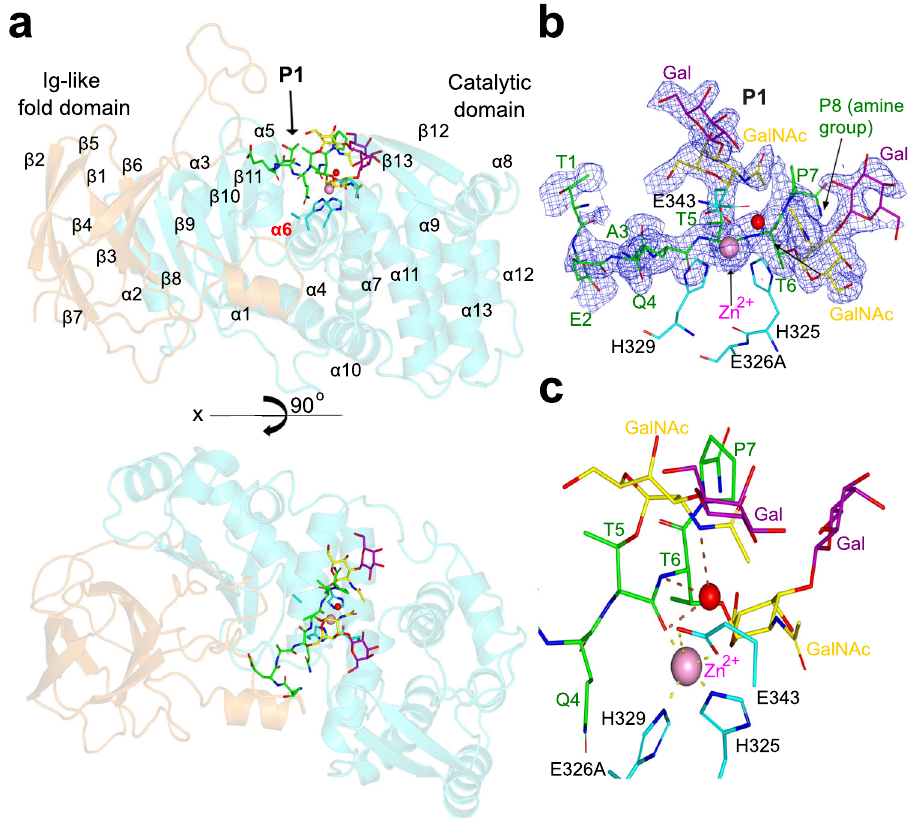
Fig. 2 | Crystal structure of the AM0627 E326A – P1 – Zn 2+ complex. a Ribbon struc- tureofAM0627 E326A complexedto P1 andZn 2+ (upperpanel).Inthelowerpanel,the monomeric form is displayed in a different view. The IgG fold and the catalytic domainsarecoloredinorangeandcyan,respectively.Thesecondarystructuresare only indicated in the upper panel and α 6 is highlighted in red. The P1 amino acids are depicted with green carbon atoms whereas the GalNAc and Gal are shown as yellow and magenta carbon atoms, respectively. While the GalNAc moieties are showninyellowaccordingtotheSNFG 60 ,theGalmoietiesareshowninmagentafor illustration purposes. The Zn 2+ and a water molecule are shown as a pink and red sphere, respectively. b Close-up view of the active site showing the bound Zn 2+ , a